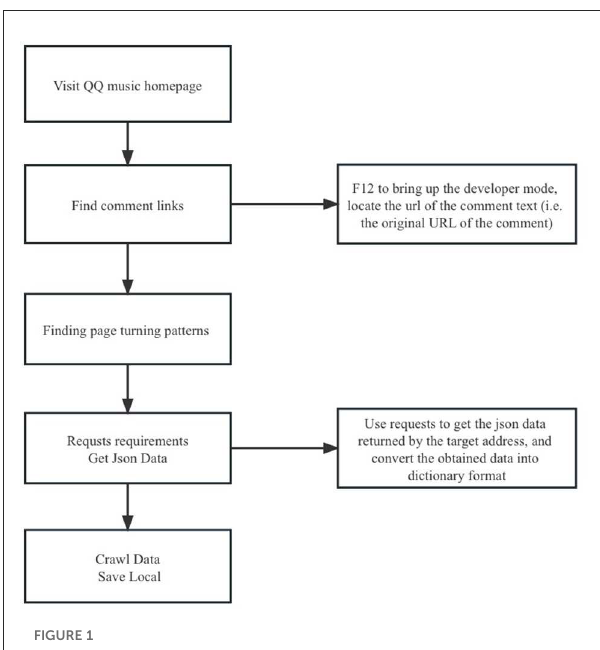
FIGURE1 QQ music comment text data crawling